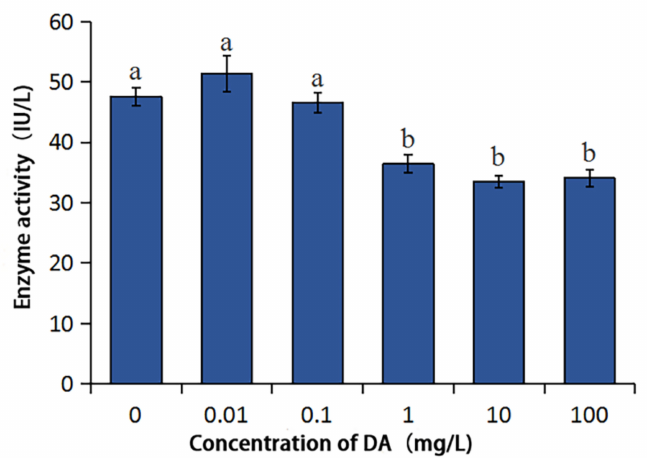
Figure 5. Effect of DA on the enzymatic activity of BmDPP3. Using the DMRT to analyze, different lower case letters in the figure indicate the significant differences between groups ( p <